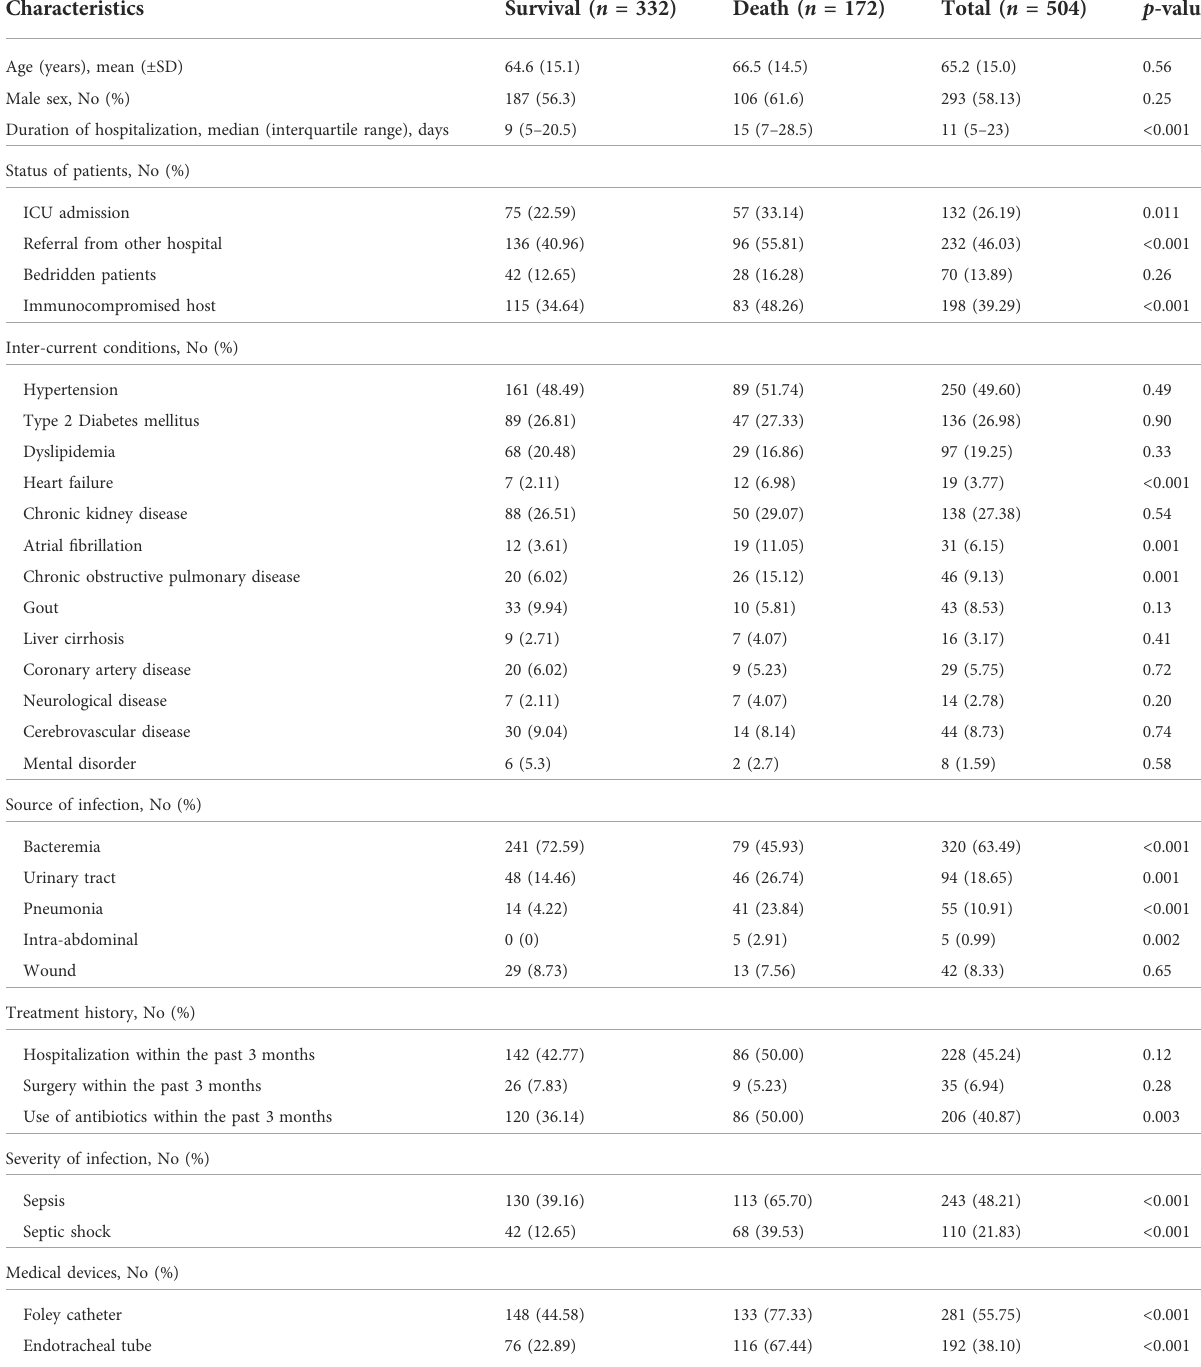
TABLE 1 Baseline characteristics of patients with